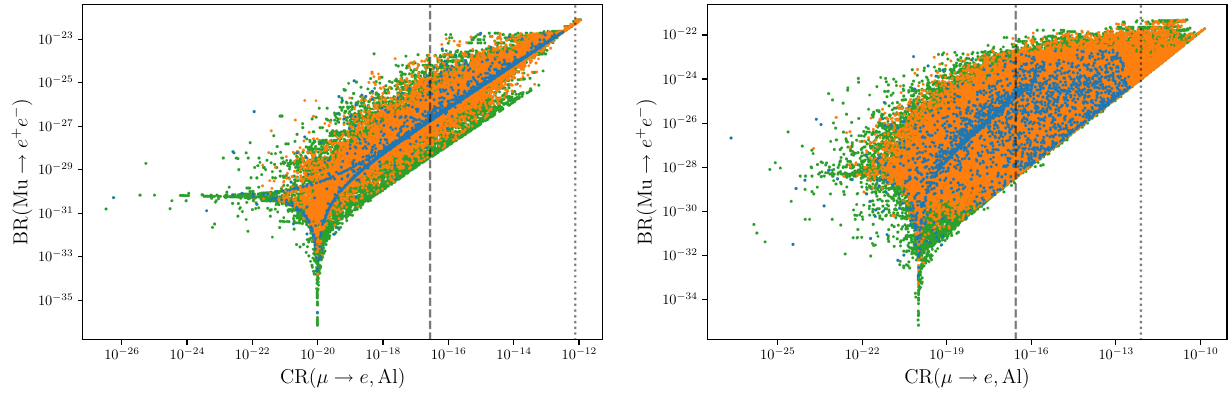
Fig. 15 Correlation of BR(Mu → ee ) and CR( μ − e , Al), for varying values of the CPV Dirac and Majorana phases. Line and colour code as in Fig. 12. On the left panel, m 4 = m 5 = 1TeV, while on the right we set m 4 = m 5 =